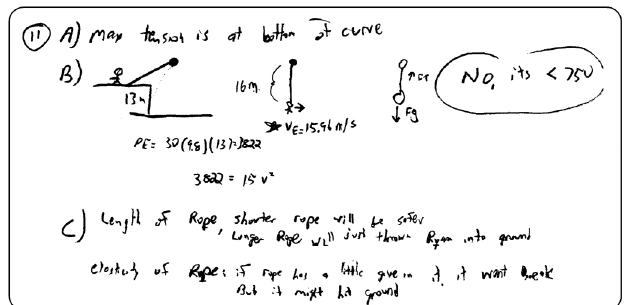
FIG. 9. Post problem solution by a student from group C.